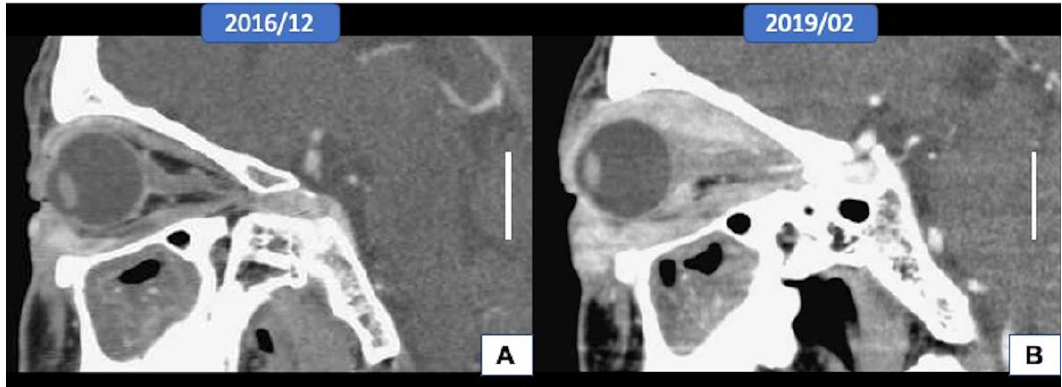
Figure 1. Radiological features of the tumor (scale bar, 2 cm). ( A , B ) The orbital computed tomographic